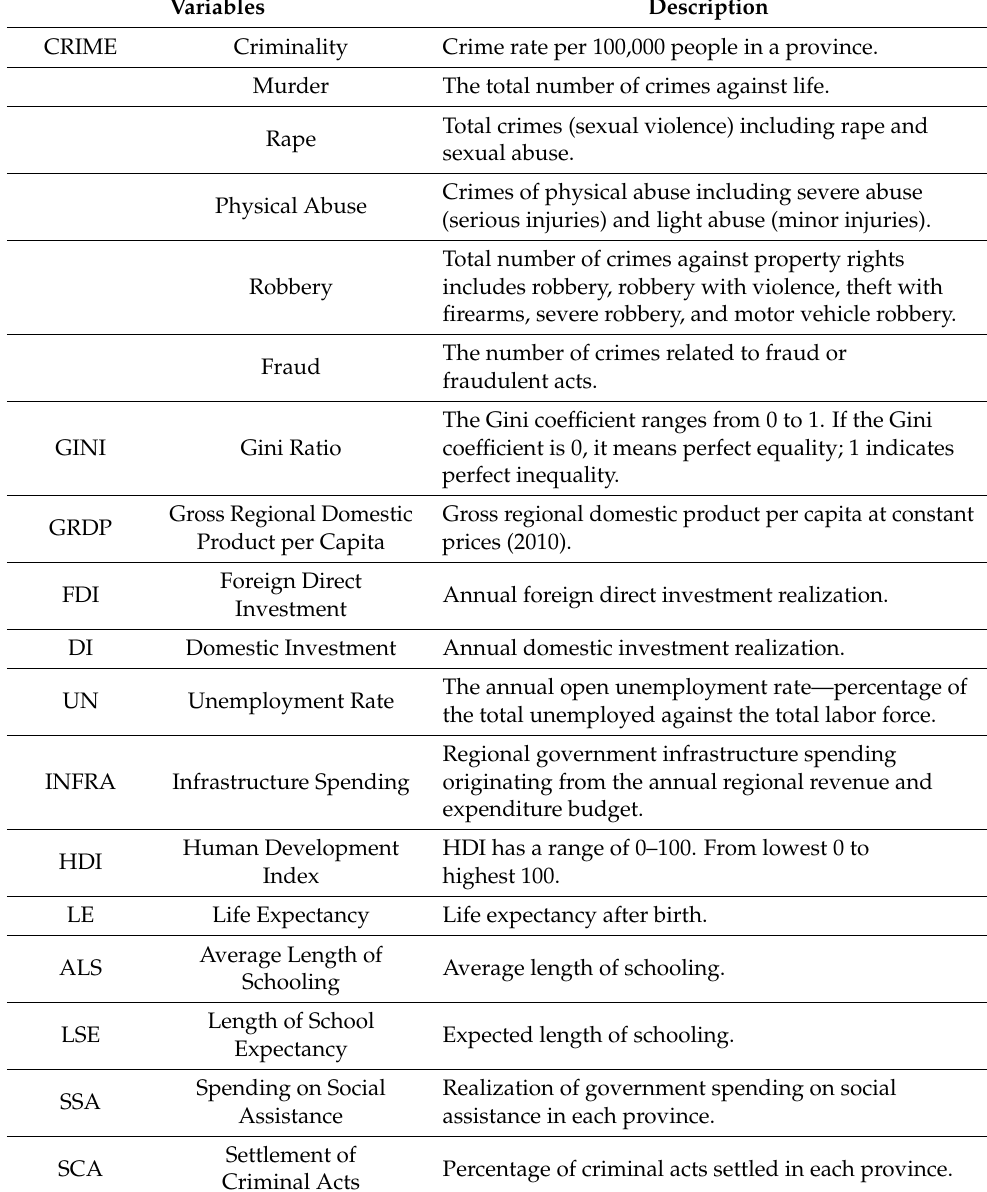
Table 1. Description of variables (annual data at province